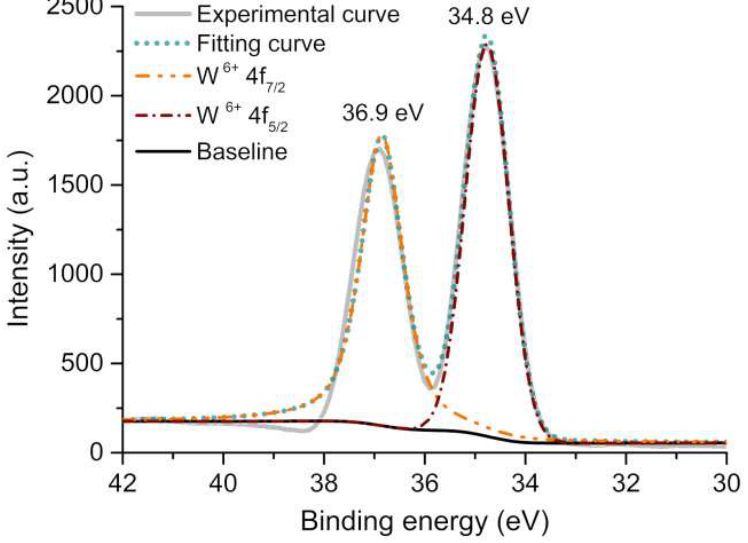
Figure 2. X-ray photoelectron spectrum (XPS) and the fitted curves of W in ZSW. The computation of Σ s can also be done using measured bond distances. The results are given in Table 2 and Figure 3. POMs can easily be protonated, as their fragments are highly negatively charged and contain abundant basic surface O atoms [36]. We can categorize the 40 O atoms in ZSW into terminal O t and bridging O µ 2 , O µ 3 , and O µ 4 types. As shown in Figure 3, delocalized protons are located on the O atoms with Σ s ranging between 0 and 1.70, which serve as proton-donors, while those O atoms with Σ s ranging between 1.95 and 2.00 hold dense electrons. Multiple protons delocalized across the entire POM fragment is a frequent occurrence that has been described in many previous studies, such as